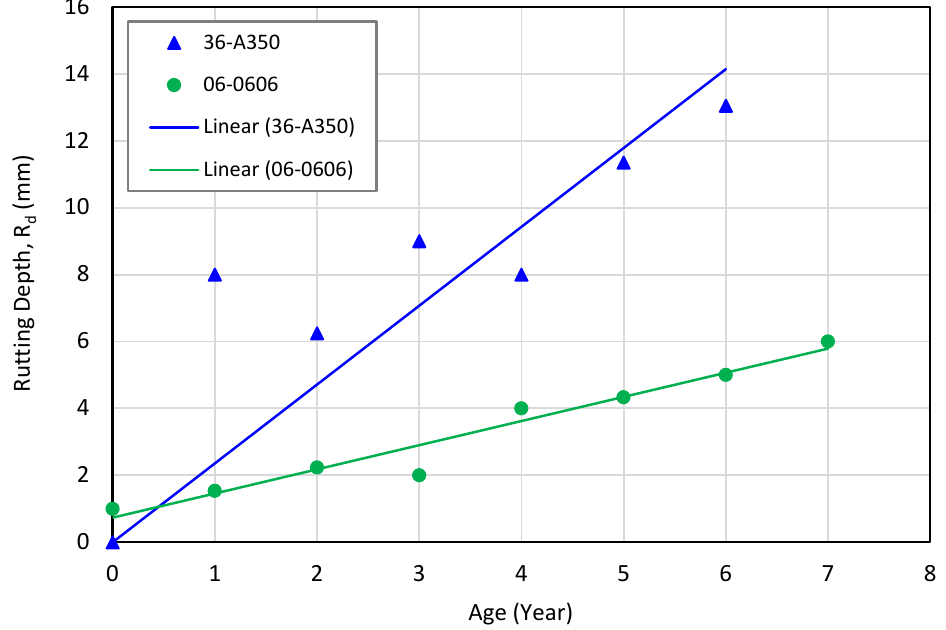
Figure 11. Rutting progression on the LTPP test sections with low structural capacity.